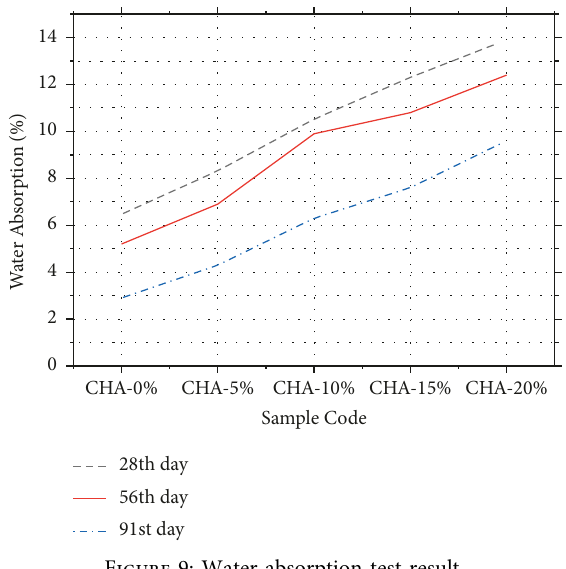
Figure 9: Water absorption test